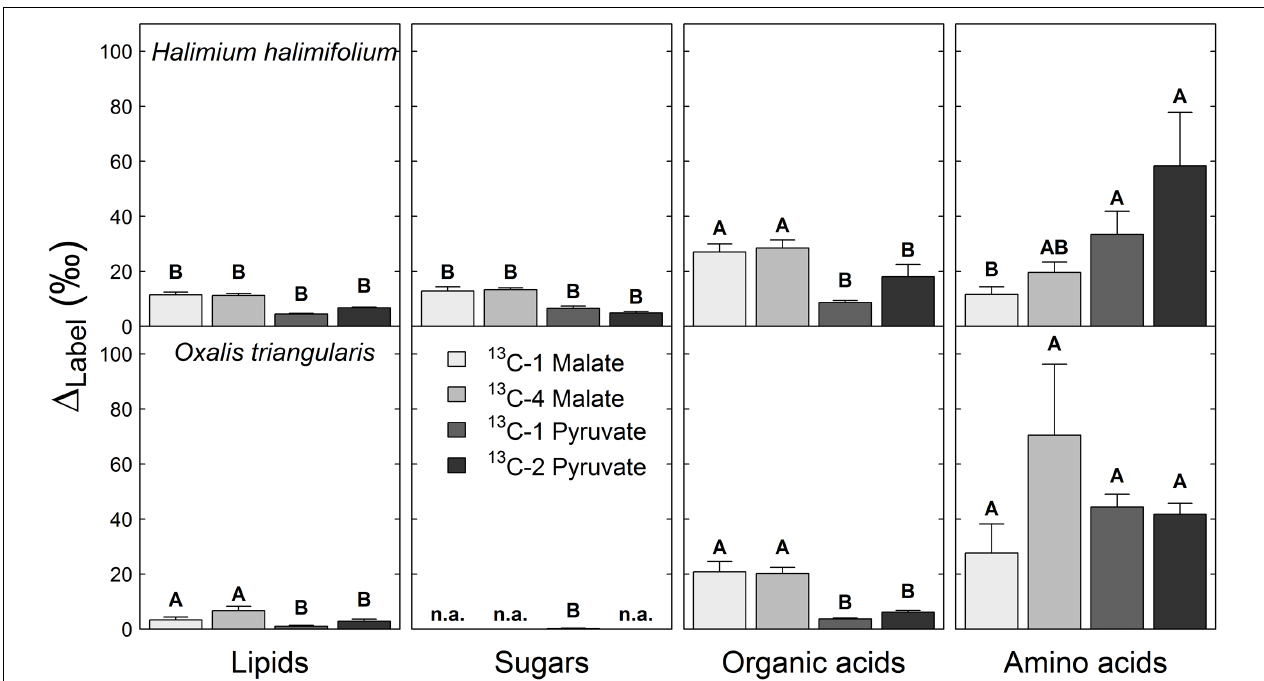
FIGURE 3 | 13 C allocation of position-specific 13 C-labeled malate ( 13 C-1, 13 C-4) and pyruvate ( 13 C-1, 13 C-2) to metabolic fractions in Halimium halimifolium and Oxalis triangularis . The label-induced 13 C increase corrected for non-labeling conditions ( (cid:49) Label , to leaf metabolic fractions. Mean (cid:49) Label values for the two harvests (20 min light or 20 min light and 20 min dark) were calculated, since no significant light–dark differences were observed for (cid:49) Label , except for lipids in plants fed with 13 C-2 pyruvate, which showed higher δ 13 C values in the dark than in the light (Table 2) . Please refer to Table 2 for the statistical analyses. n.a. indicates no observable (cid:49) Label . Capital letters denote significant differences among metabolic fractions of plants fed with the same 13 C-labeled substrate (ANOVA and Tukey-HSD). Means and SE are given ( n = 3